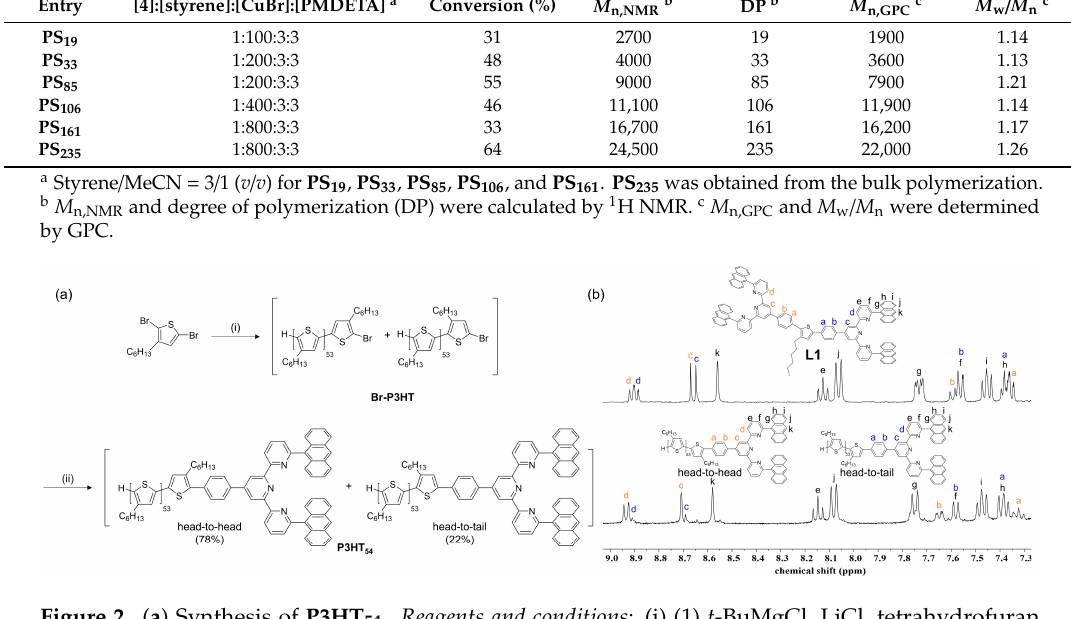
Figure 2. ( a ) Synthesis of P3HT 54 . Reagents and conditions : (i) 1) t -BuMgCl, LiCl, tetrahydrofuran (THF), 2) Ni(dppp)Cl 2 , THF, 0 °C; (ii) 6,6"-dianthracenyl-4'-(4-boronophenyl)tpy, Pd(PPh 3 ) 4 , NaOH, THF/H 2 O (3/1, v/v), reflux. ( b ) 1 H NMR spectra of ligand L1 and P3HT 54 .